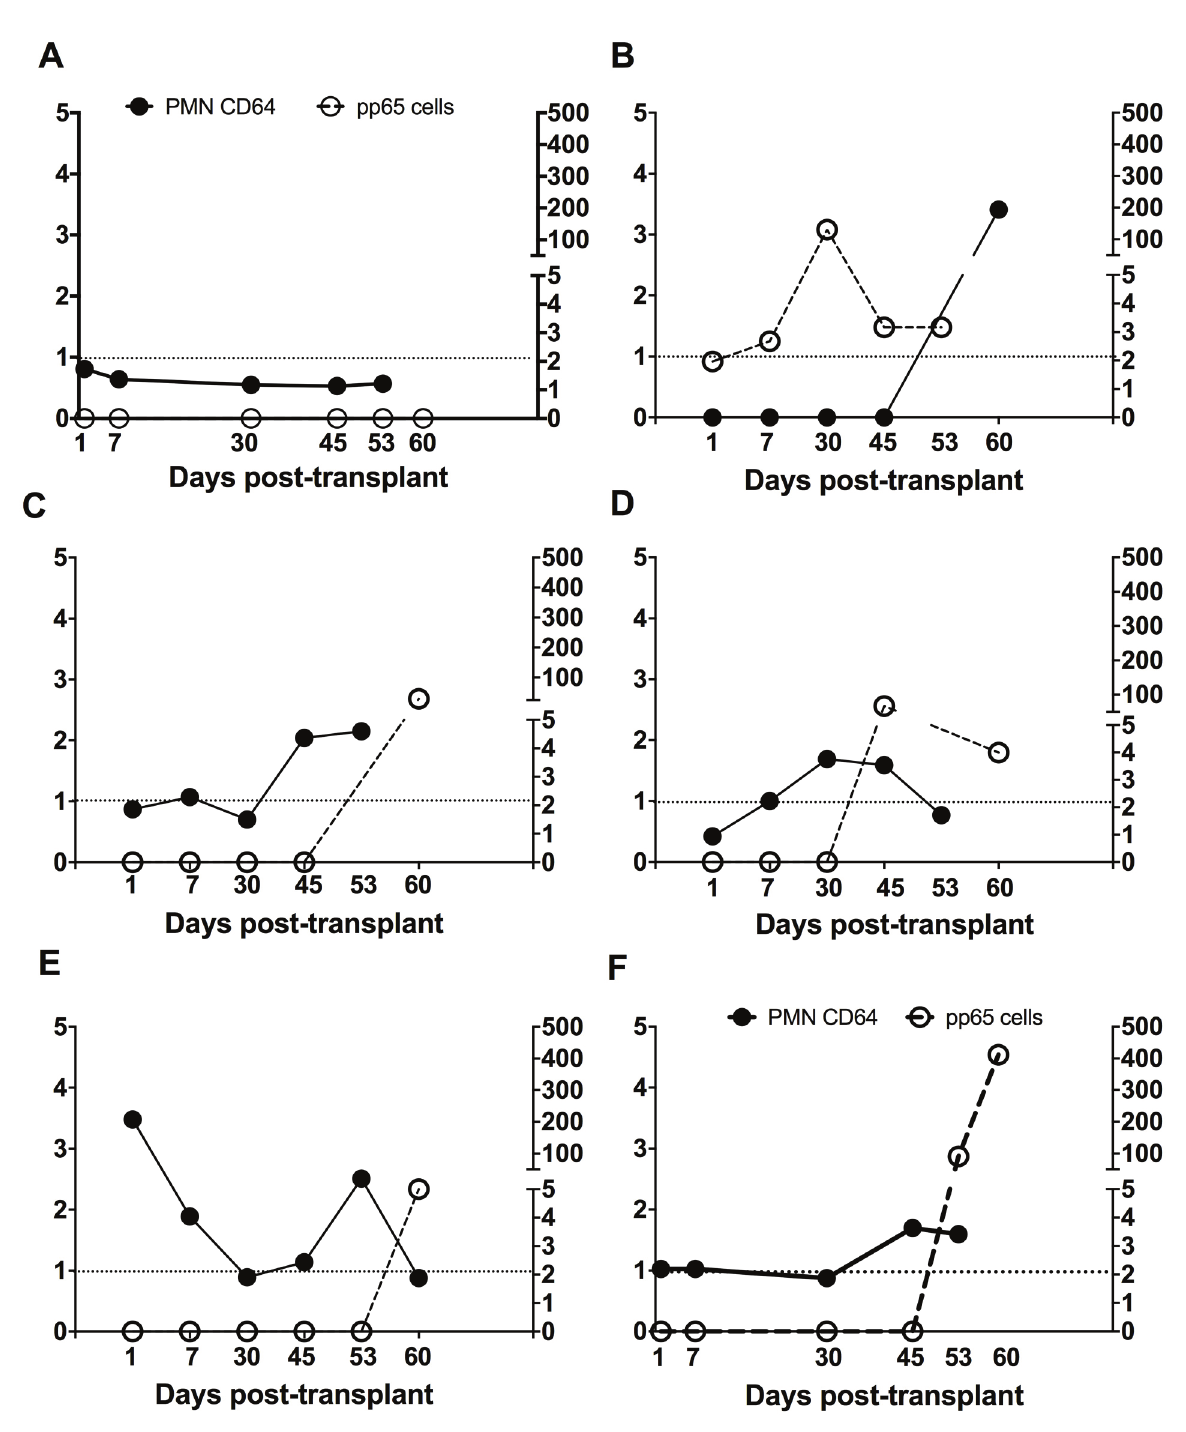
figurE − Profile of PMN CD64 index and pp65 antigenemia from recipients followed for sixty days after kidney transplantation A) an asymptomatic recipient representative of the control group without HCMV infection; B-D) three kidney recipients that developed HCMV infection/disease after transplantation; E) kidney recipient with HCMV infection/disease, which had heart attack during surgery; F) mean value of PMN CD64 and positivity of pp65 cells of nine patients with HCMV infection/disease. The mean values of PMN CD64 expression to each point – day 1: 1.027; day 7: 1.027; day 30: 0.874; day 45: 1.700; and day 53: 1.595. Additionally, mean values of pp65 positive cells were day 1: 0; day 7: 0; day 30: 0; day 45: 0; day 53: 90.42; and day 60: 411.40. PMN: polymorphonuclear neutrophils; HCMV: human